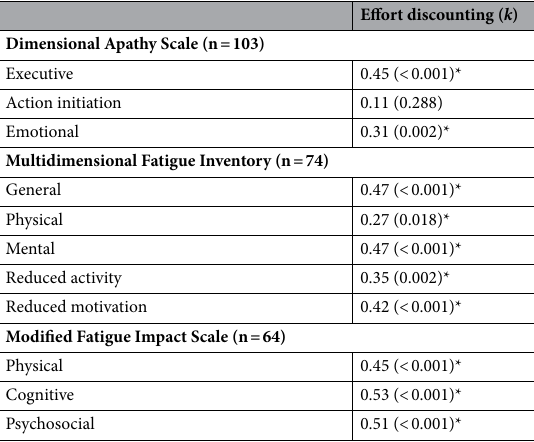
Table 3. Correlation coefficients (Spearman’s ρ) between effort discounting ( k -values) and responses on the DAS, MDFI and MFIS. Other than the Action Initiation subscale of the DAS, k -values were significantly positively correlated with all subscales of all inventories. p -values are indicated in parentheses, with asterisks indicating those that survived FDR correction at a threshold of α =